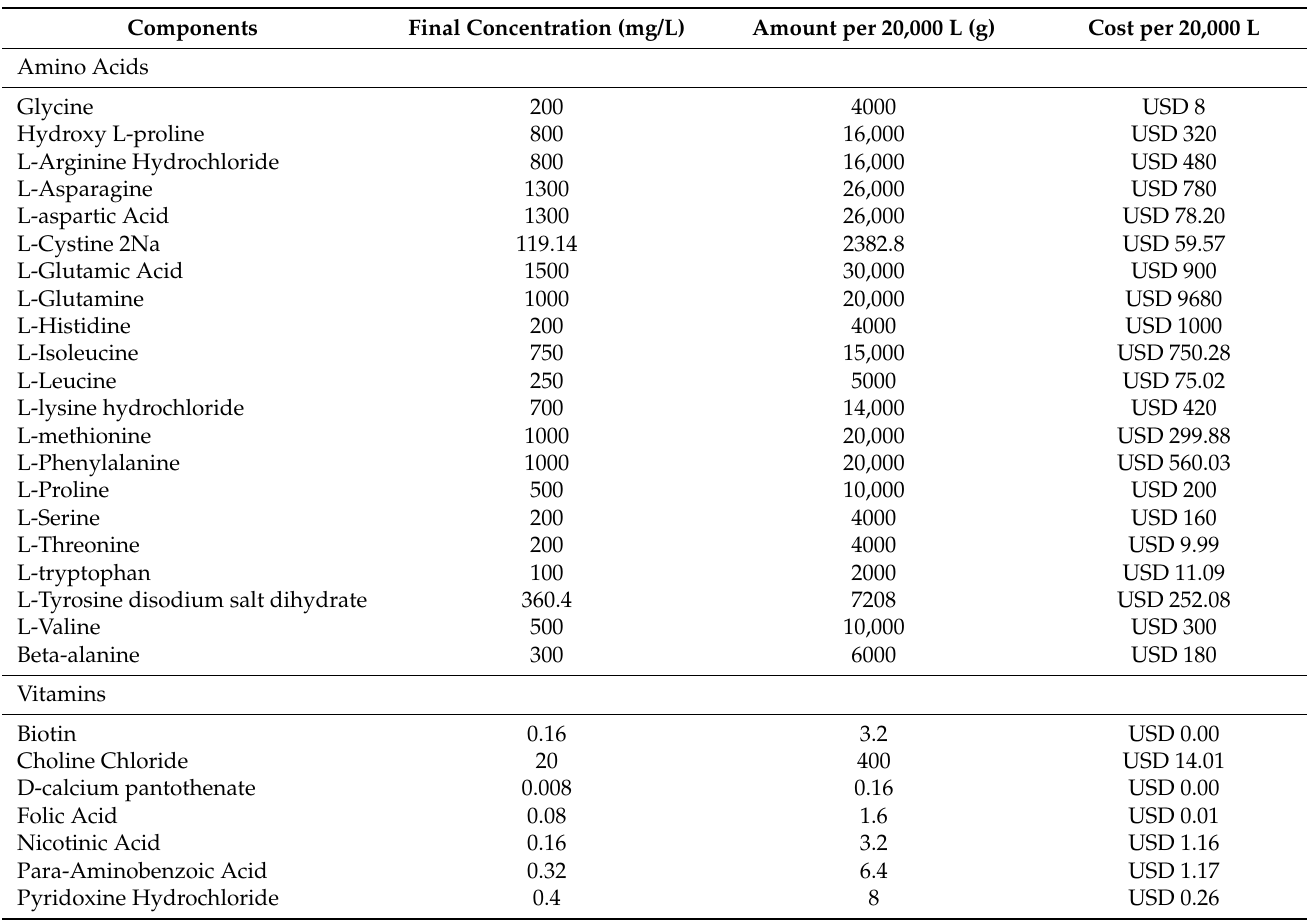
Table A4. Cost of components within IPL-41 basal medium and their relative cost contribution to a hypothetical 20,000 L